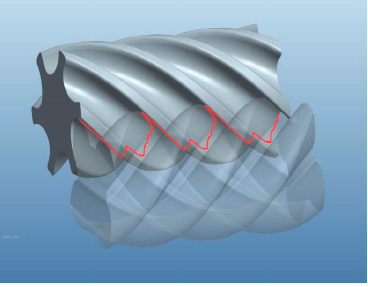
Figure 5. Contact line formed between rotors.